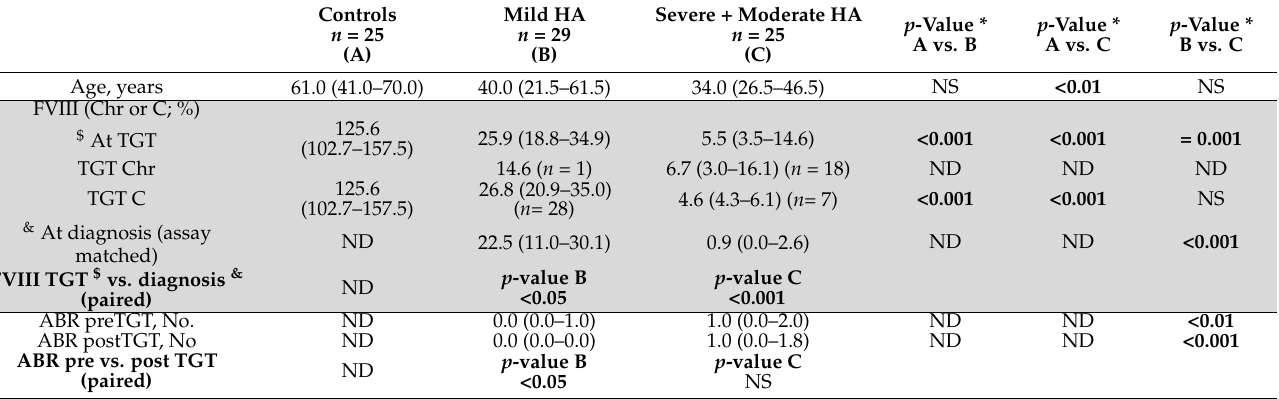
Table 2. Clinical characterization of the HA cohort and healthy controls at the time of